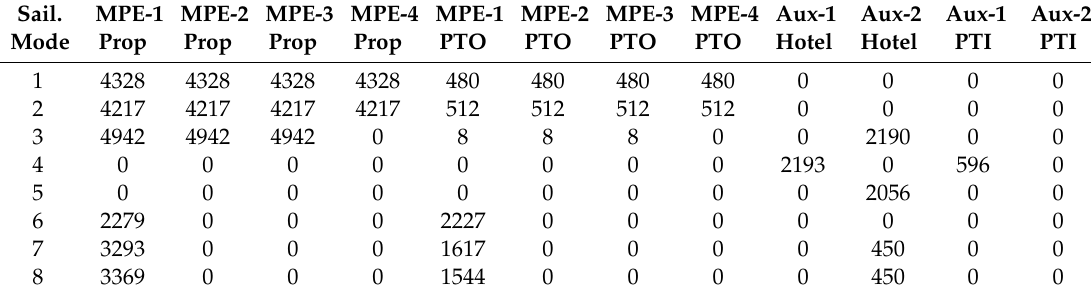
Table 9. Cruise ship: MILP unit